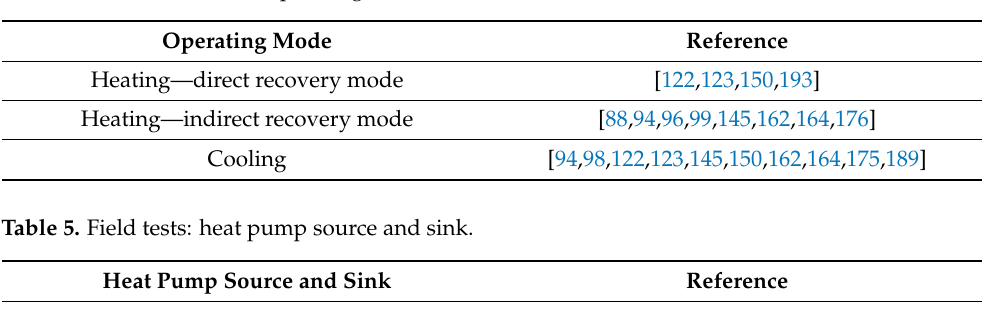
Table 4. Field tests: GEHP operating mode.